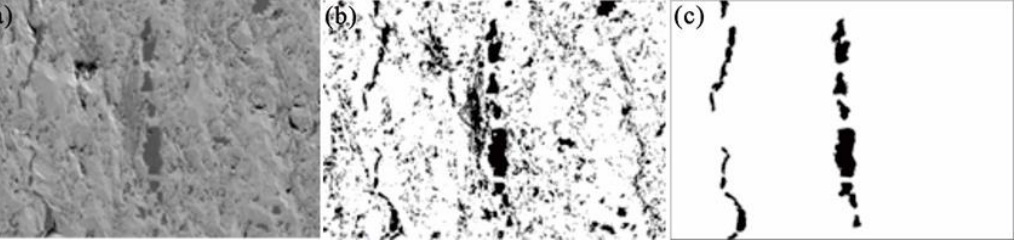
Figure 5. Graptolite area extraction steps by SEM images. ( a ), primary SEM image; ( b ), binary image; ( c ) graptolite area extraction. Table 3. Distribution characteristics of the reflectance of graptolites and equivalent vitrinite of the Longmaxi shales. Table 3. Distribution characteristics of the area of graptolite and organic matter in the Longmaxi shales. Sample No. Sample